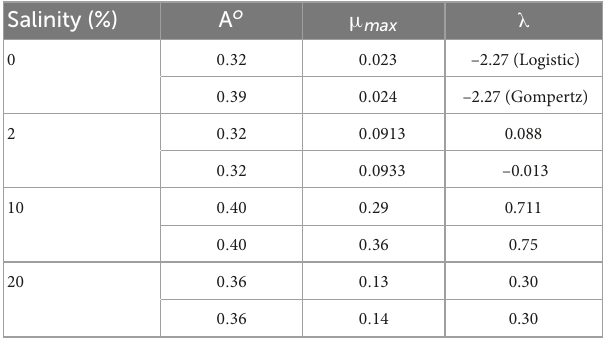
TABLE 2 Parameters (A, λ , and µ m) of non-linear fit for various functions used in the article. Salinity